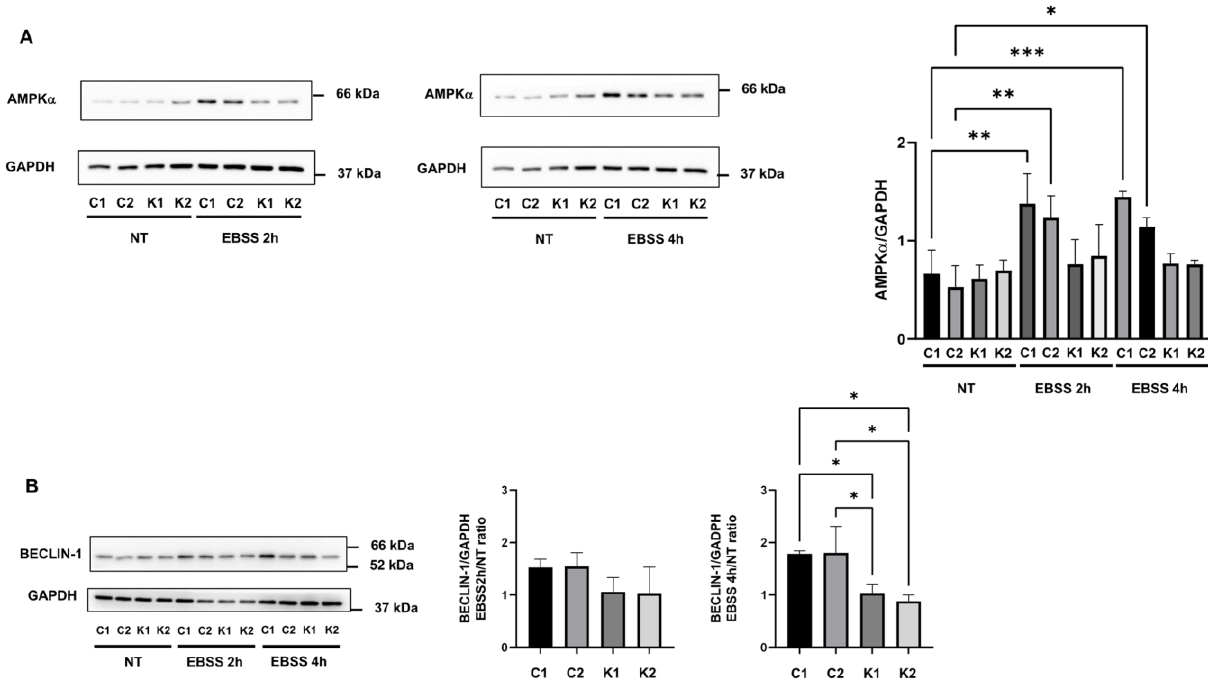
Figure 2. Representative Western blotting images and densitometric analysis of ( A ) AMPK α and ( B )